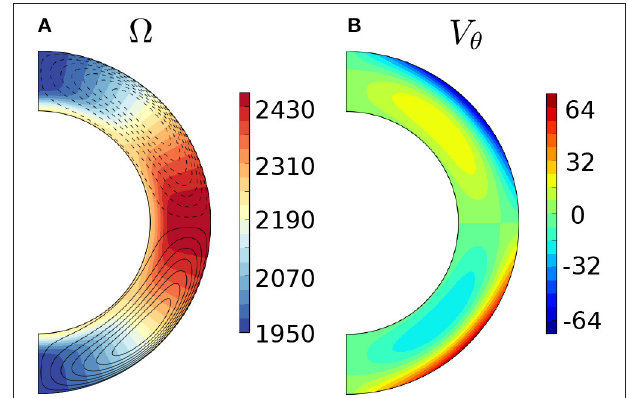
FIGURE 1 | Plots of longitudinally averaged (A) differential rotation ( (cid:127) ) superimposed with the meridional flow (dashed lines: counter-clockwise, solid lines: clockwise) and (B) latitudinal velocity ( V θ ) in the convection zone. Here (cid:127) and V θ are in non-dimensional units. In dimensional units, V φ ( = rsin θ (cid:127) ) ≈ 2 km / s at the surface near the equator and V θ ≈ 20 m / s at the surface (latitude: ± 45 ◦